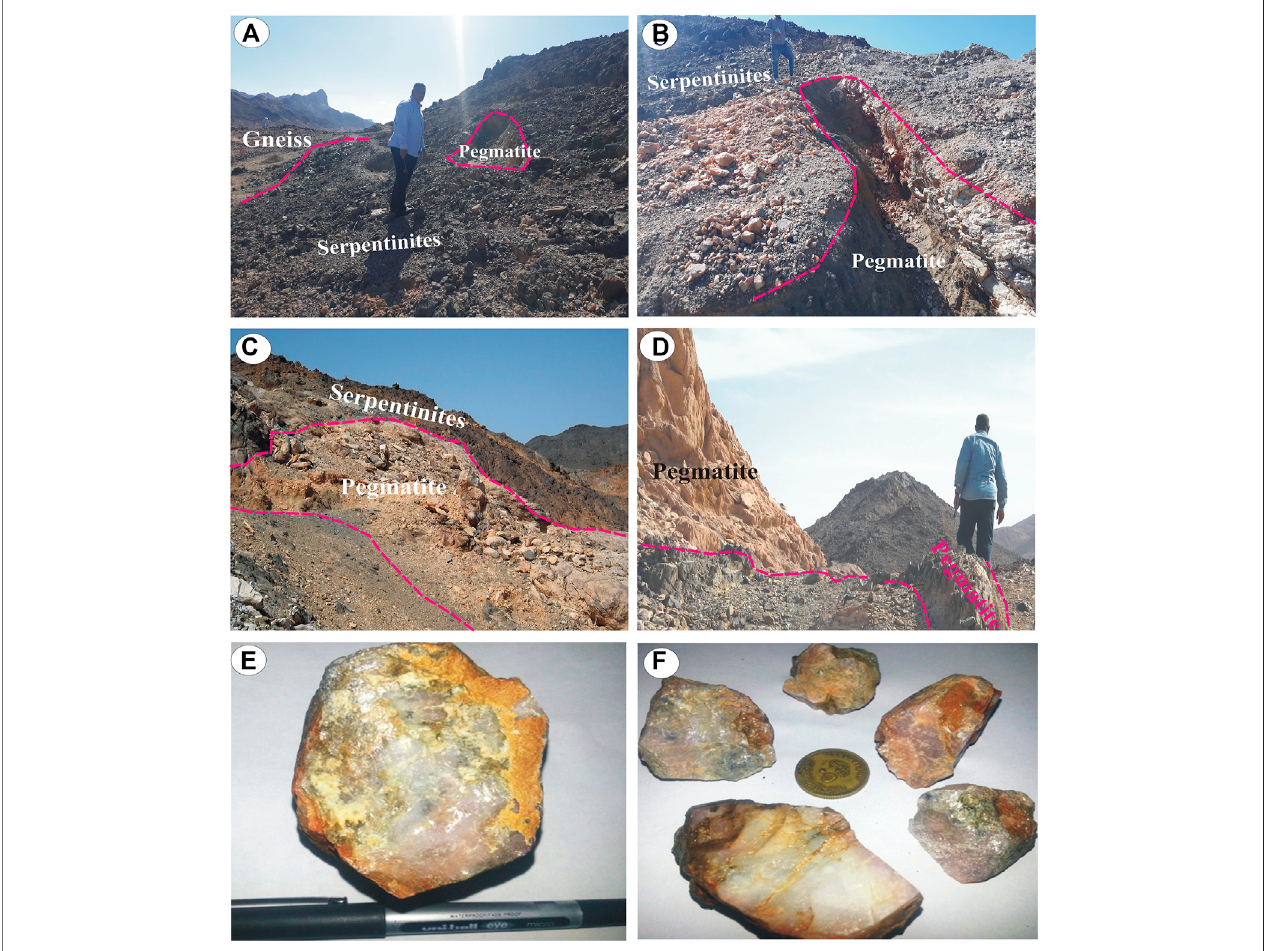
FIGURE 3 | Field photographs showing corundum-bearing pegmatite veins invading (A) gneiss and (B – D) Serpentinite rocks and (E,F) hand specimen of corundum minerals.